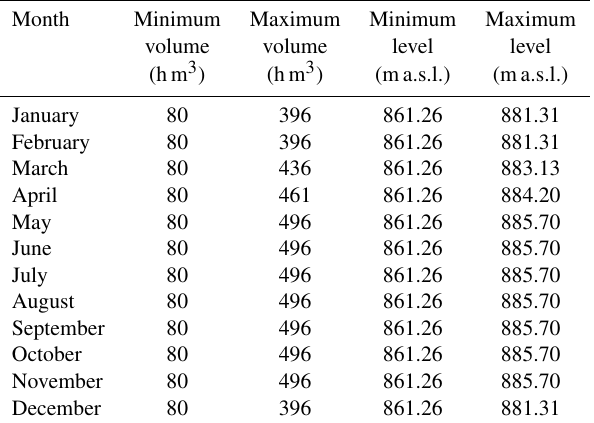
Table 2. Seasonal minimum and maximum volumes (hm 3 ) and wa- ter levels (ma.s.l.) for the Santa Teresa